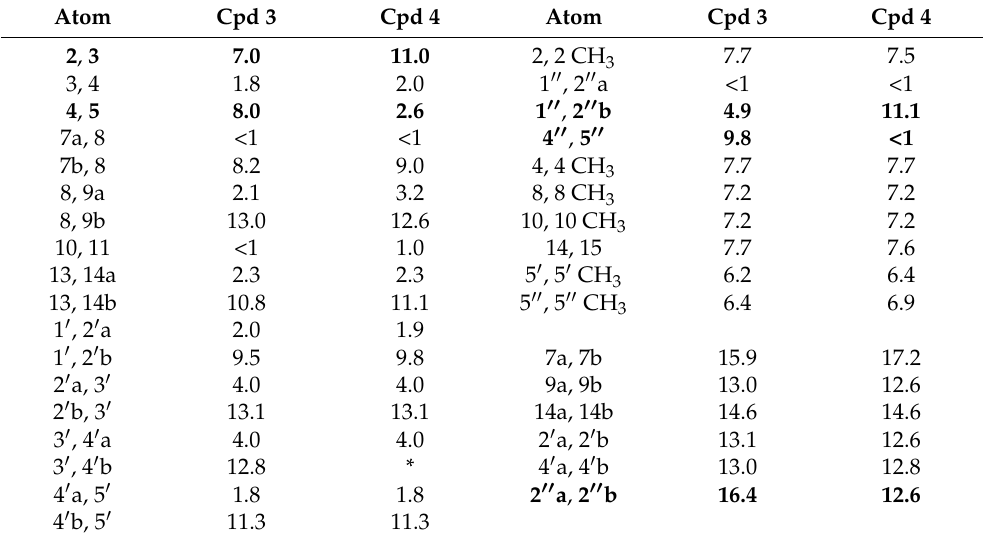
Table 2. Comparison of 3 J H,H (Hz) coupling constants for 3 and 4 in D 2 O at 25 ◦ C; differences marked in